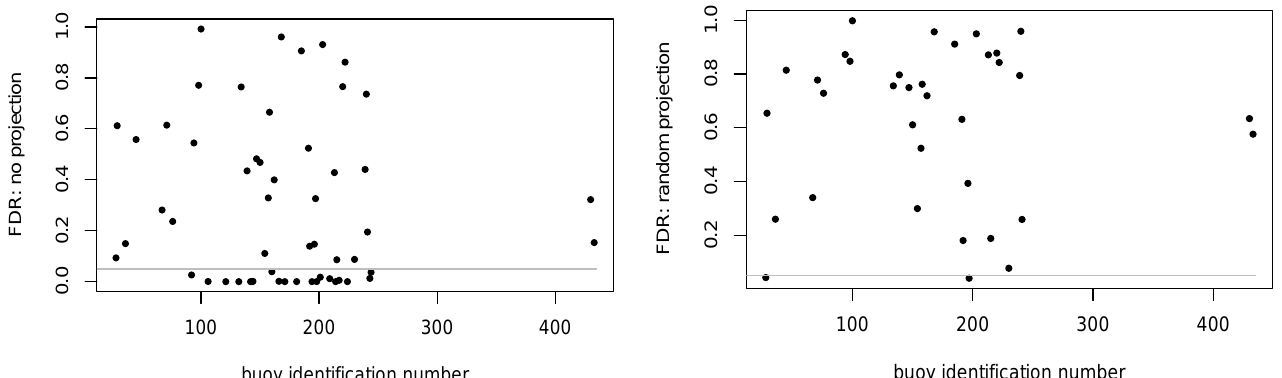
Figure 4. Left panel : FDR values corresponding to the studied buoys in Table 4. Right panel : FDR values corresponding to the buoys studied in Table 5. The line y = 0.05 is displayed in both panels in color